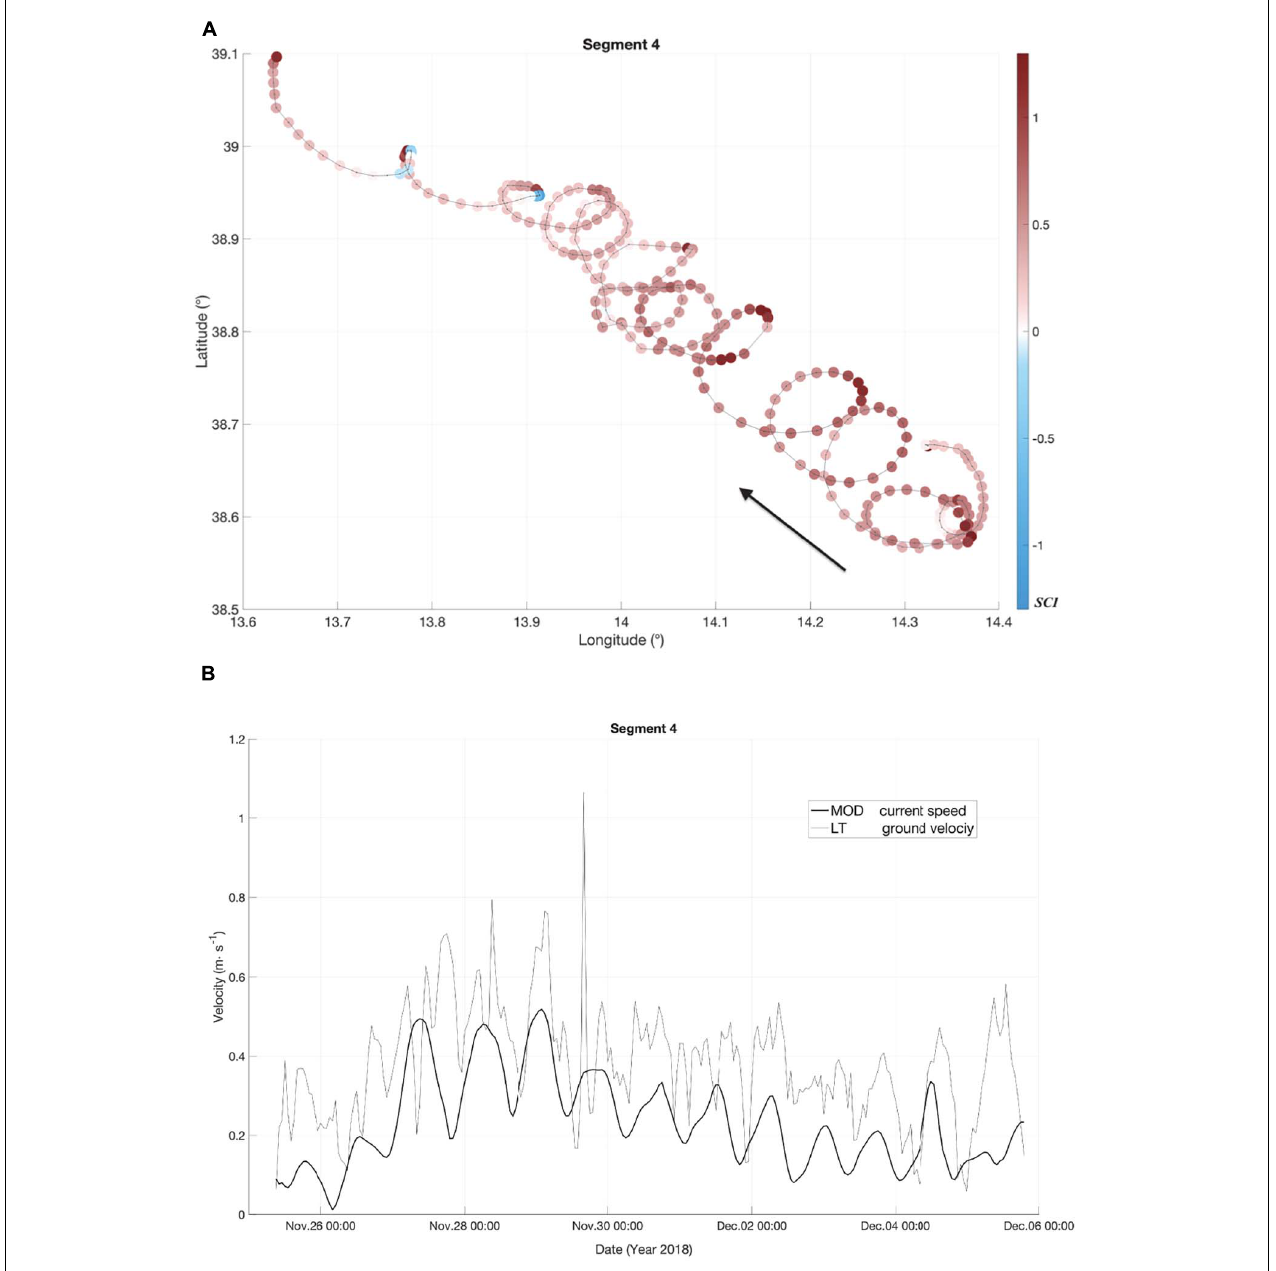
FIGURE 6 | (A) Segment 4 of the loggerhead turtle (LT) trajectory (black line; see also Figure 4 ) with SCI values at sampling points. The black arrow indicates the general direction of the motion along this segment. (B) Intensity of LT ground velocity (thin gray line) and MOD sea current velocity (thick black line) along this